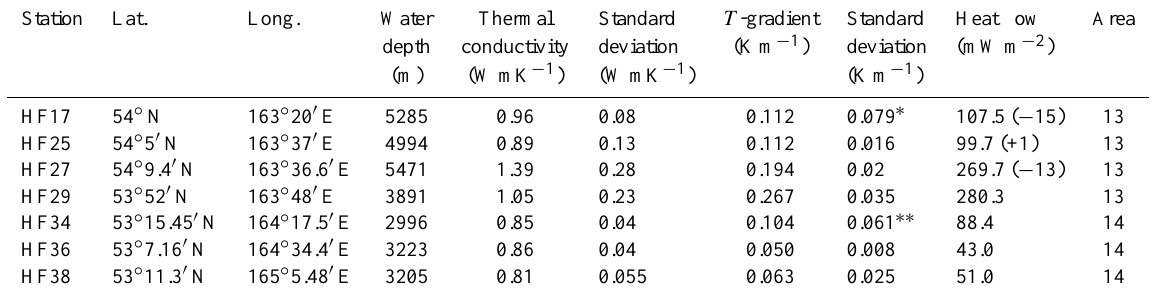
Table 1. Summary of the measured heat flow values during KALMAR 20. Values in brackets indicate order of magnitude of site-specific terrain correction (see also Sect. 5).